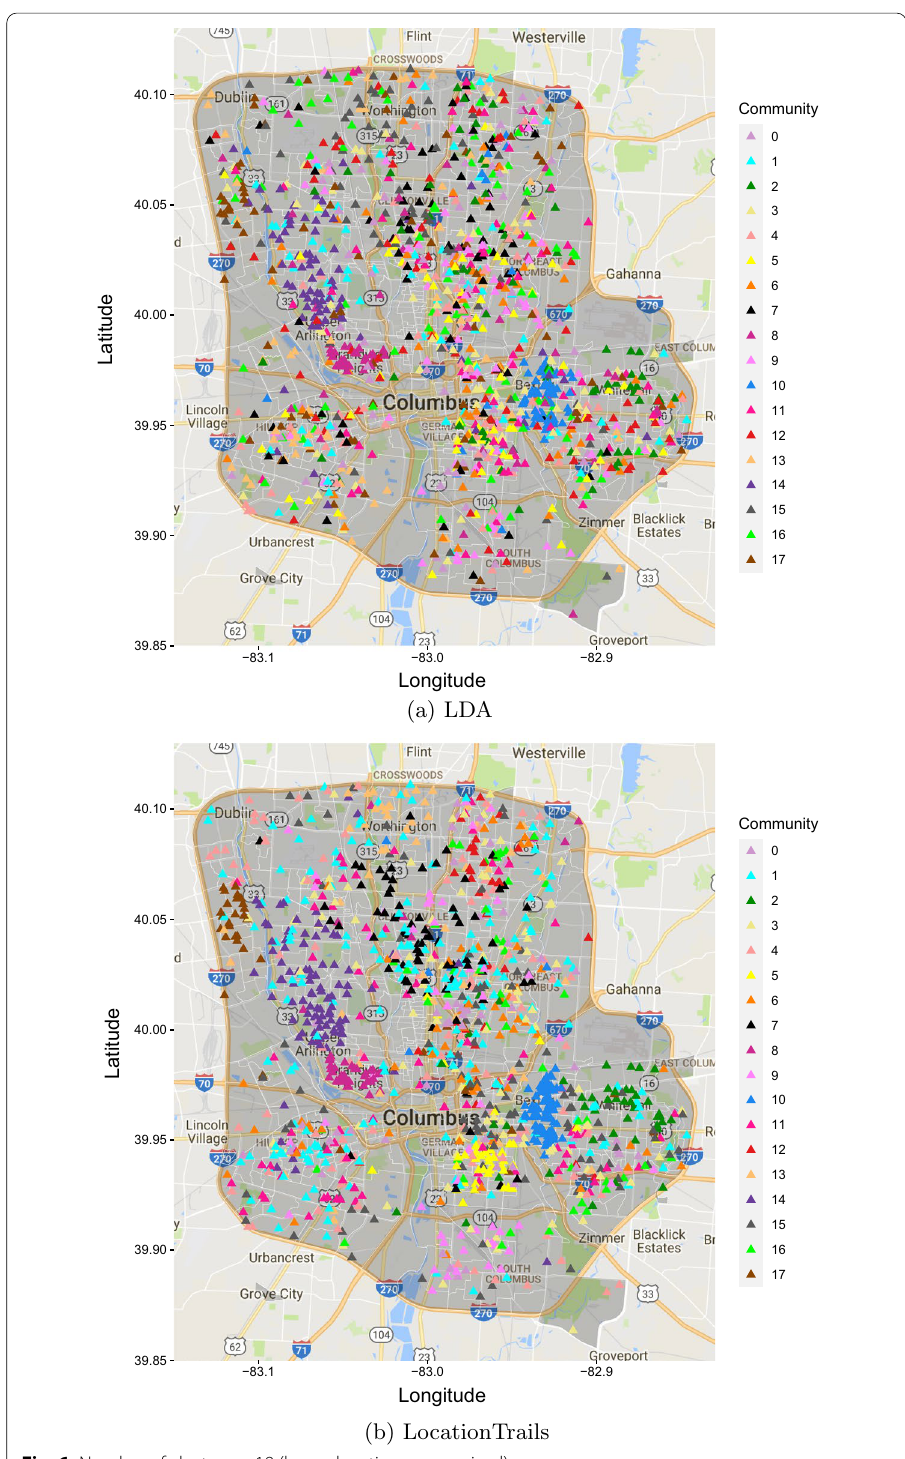
Fig. 6 Number of clusters